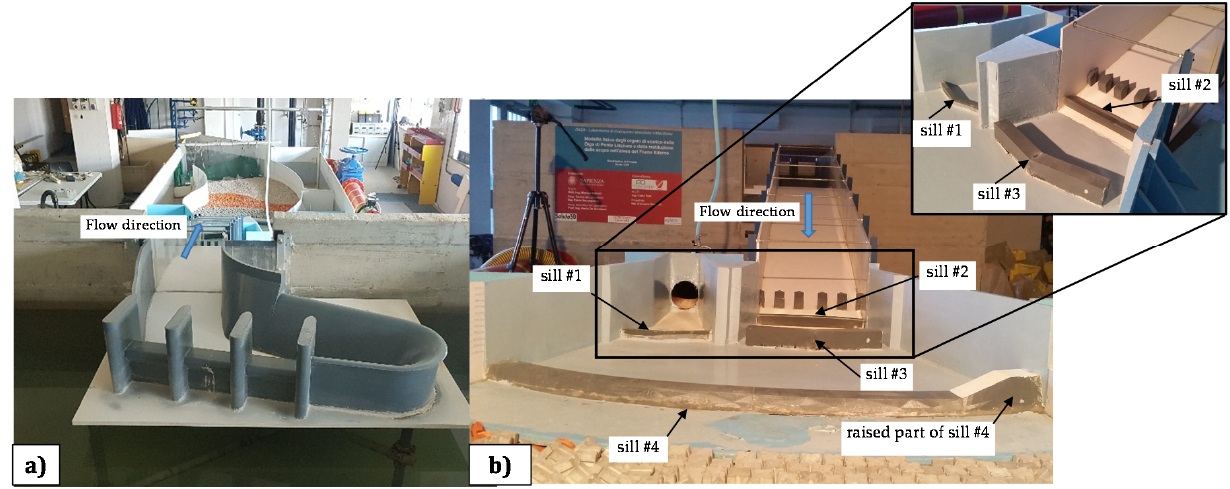
Figure 4. Laboratory model: ( a ) surface spillway; ( b ) chute, bottom outlet terminus, sills, and stilling basin. The stilling basin is equipped with the 4 sills described in Section 2 and shown in Figure 4. Sill#4 is configured with a greater height at the orographic left to better